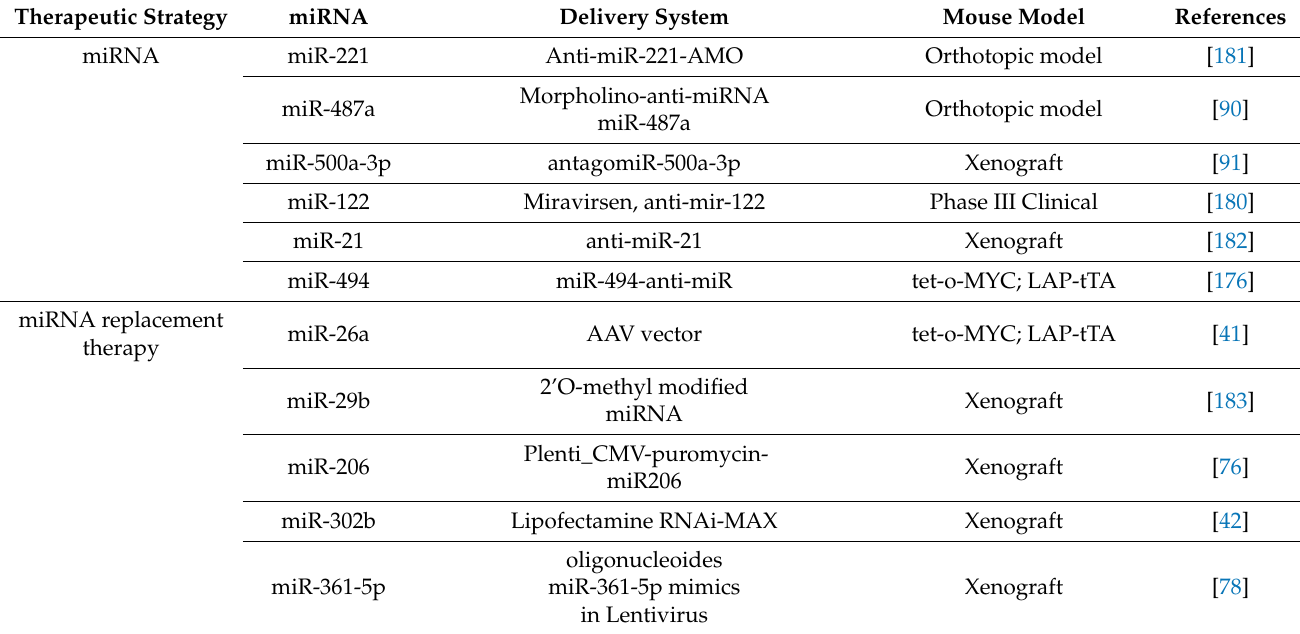
Table 3. miRs in HCC